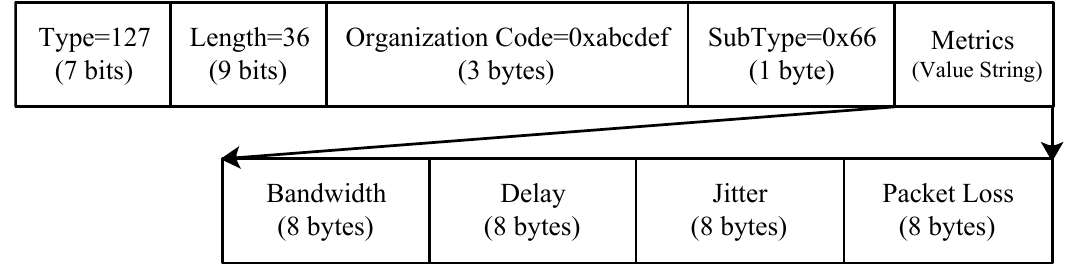
Figure 2. MonLink packet